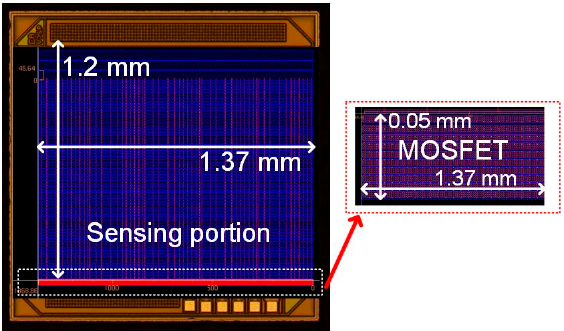
Figure 4. ( a ) Characteristics I D – V DS and ( b ) I D – V GS curves for a single transistor element with W/L = 4.21/1 µm/µm.